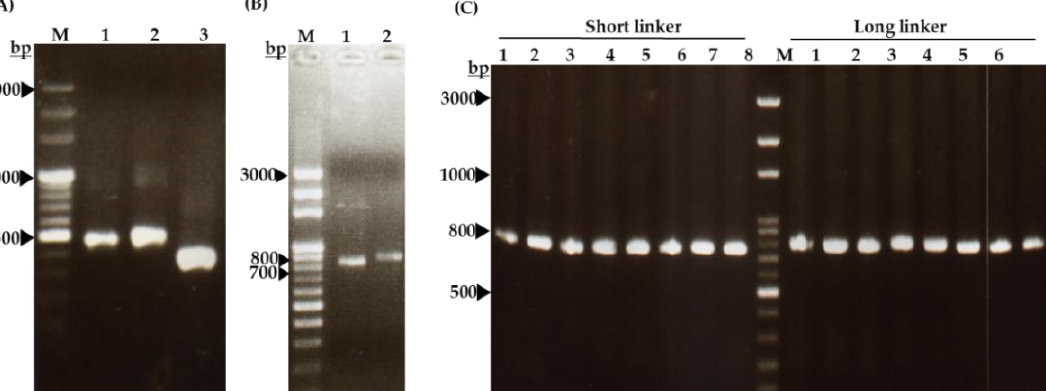
Figure 4. Construction analysis of the scFv-binding protein antibodies phage display libraries and insert confirmation. PCR products of lane 1: V H -S (variable region of heavy chain with short-linker); lane 2: V H -L (variable region of heavy chain with long-linker); and lane 3: V L (variable region of light chain) ( A ). PCR products of the scFv-S (lane 1) and scFv-L (lane 2) ( B ). PCR amplification of full-length scFv genes from the phage display library for confirming insertion frequency ( C ). Lanes 1–8: scFv genes containing V H -peptide linker-V L fragments with short- or long-linkers, respectively. All three panels have DNA ladder (lane M) as a reference point.